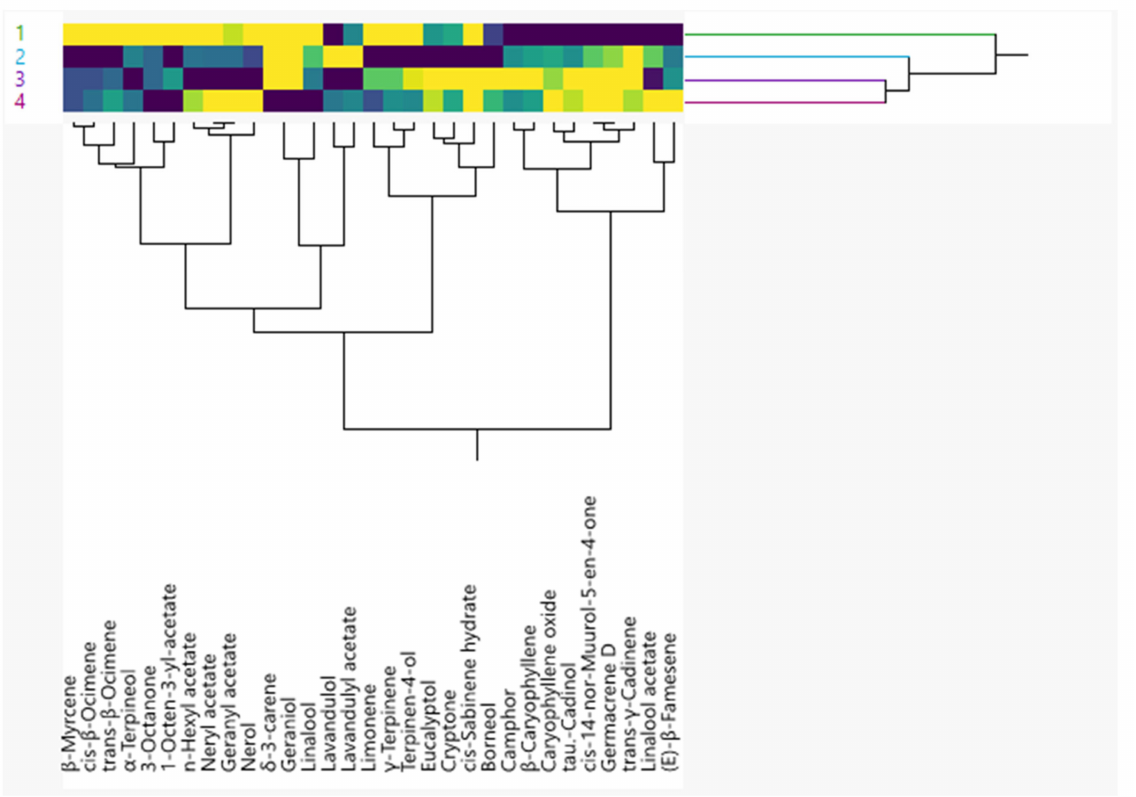
Figure 2. Two-way hierarchical cluster analysis performed using Ward’s methods for lavender